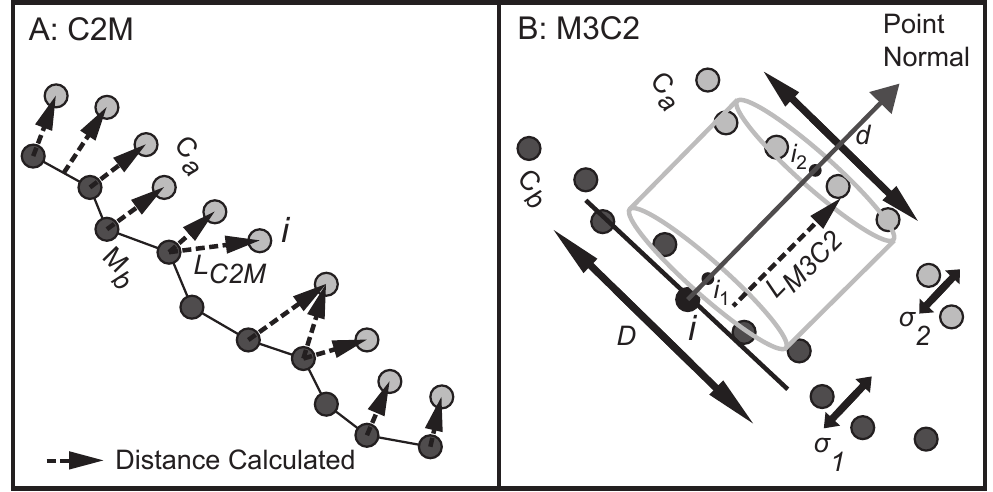
Figure 1. Conceptual diagrams of the C2M and M3C2 techniques. ( A ) The shortest distances between C and M are computed and stored as attributes of C . ( B ) The point a b a normal for i is calculated using the scale, D . A cylinder with diameter d and a user-specified maximum length is used to select points in C and C for the calculation of i and i , b a 1 2 respectively. L is the distance between i and i and is stored as an attribute of i . The M 3 C 2 1 2 local and apparent roughness of C and C are calculated as σ and σ , respectively, which b a 1 2 are used to calculate the SVCI for i . Both A and B are modified from Lague et al. [22]. A: